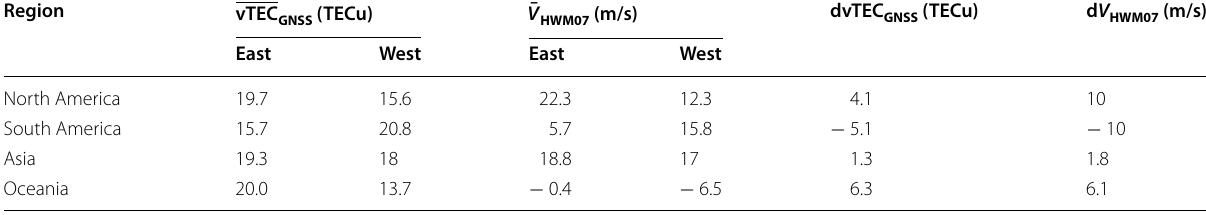
, V , and the east–west difference, dvTEC GNSS HWM07